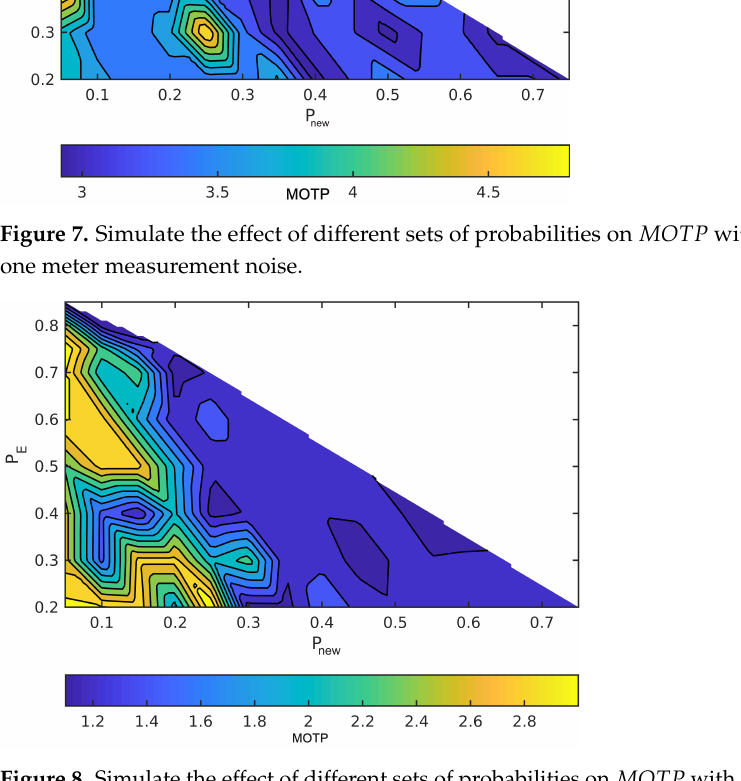
Figure 8. Simulate the effect of different sets of probabilities on MOTP with dynamic VRUs and with one meter measurement